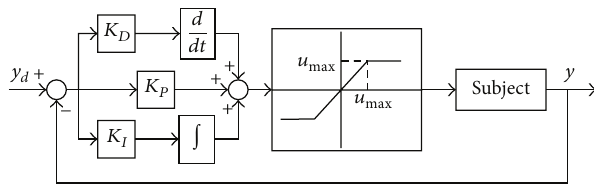
Figure 2: The schematic of the saturated controller (20) using sliding manifold equation (6).